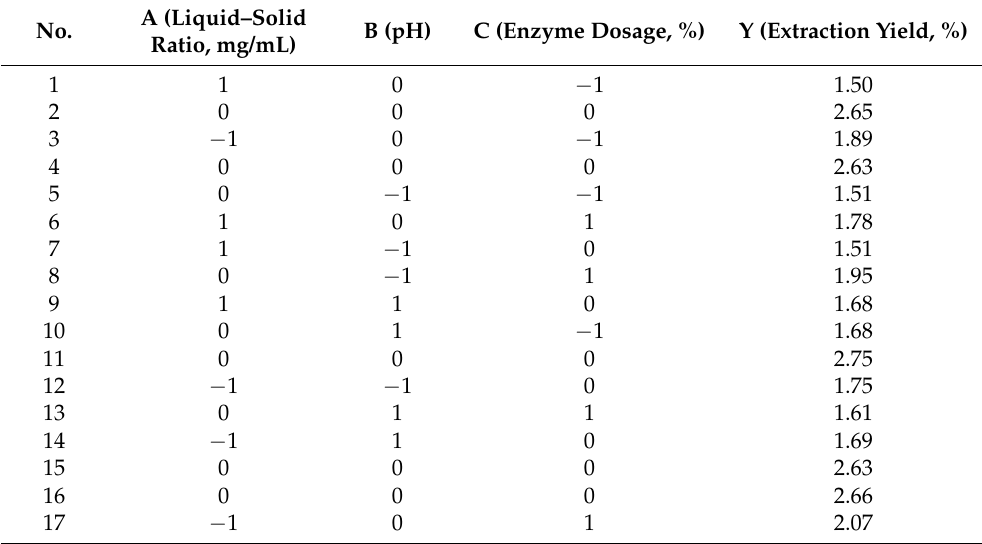
Table 2. Box–Behnken test design scheme and